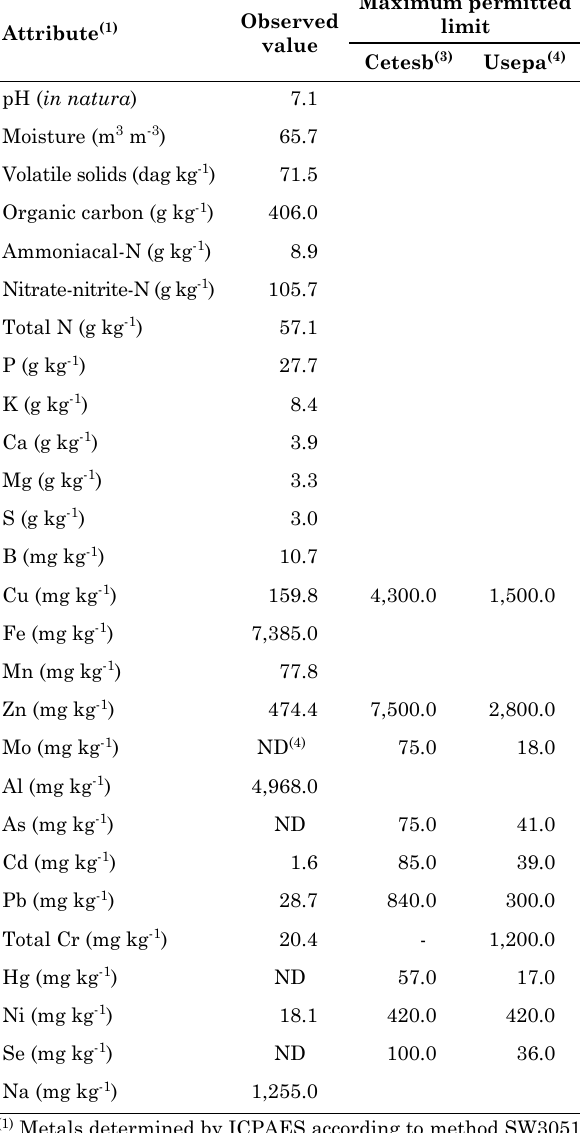
table 1. chemical and physical characterization of the sewage sludge, with maximum permitted limits